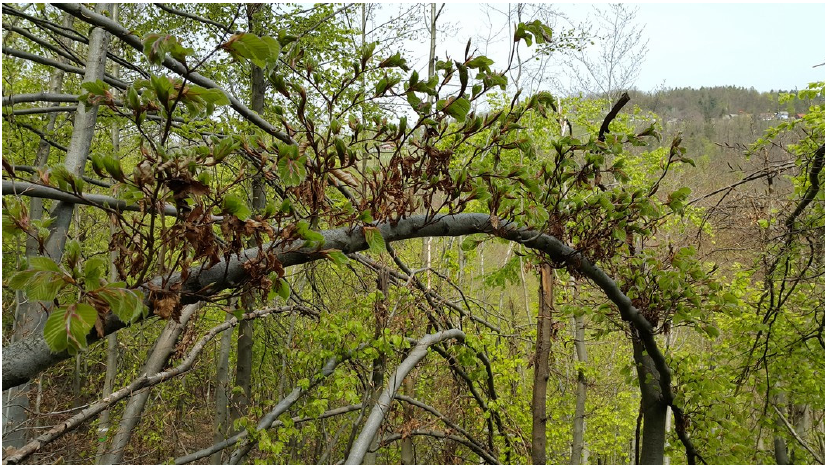
Figure 2. Broadleaved pole stands damaged by wet snow in southeast Slovenia in October 2012. The figure depicts vigorous re-sprouting of bent beech poles in summer 2015, which will reduce the future commercial value of the stand.